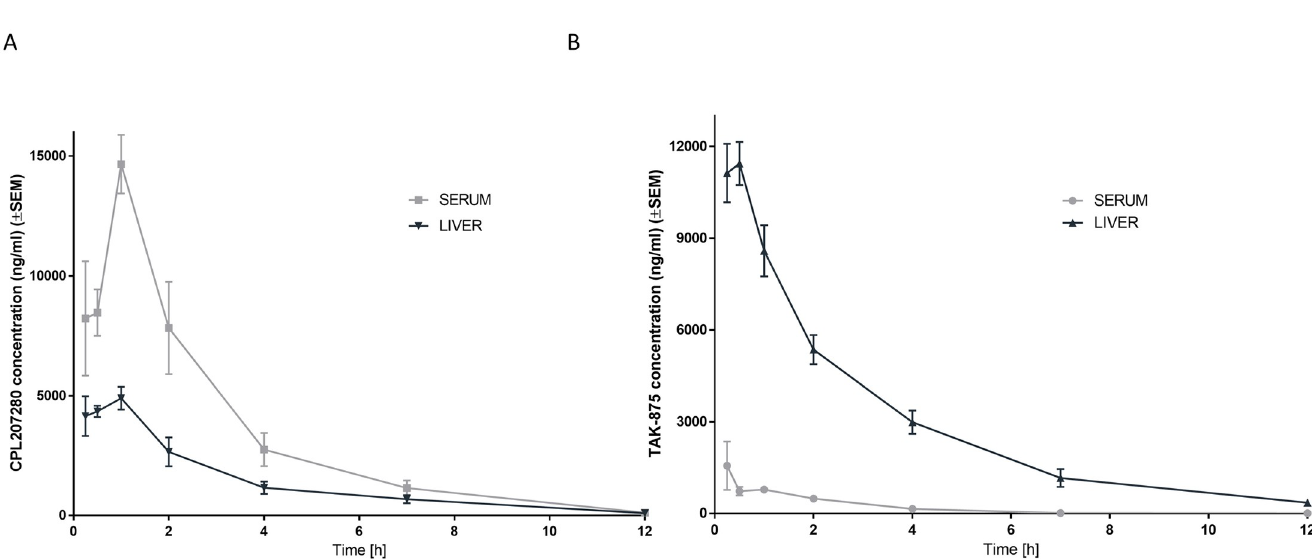
Fig 6. Pharmacokinetic profiles in mice. Concentrations of CPL207280 (A) and TAK-875 (B) in serum and liver. Data are represented as mean ± SEM (n = 3) concentrations of the compounds in mouse plasma and liver following a single oral administration. Note that CPL207280 shows greater concentrations in serum than in liver in contrast to TAK-875, which tends to mainly occur in the liver.